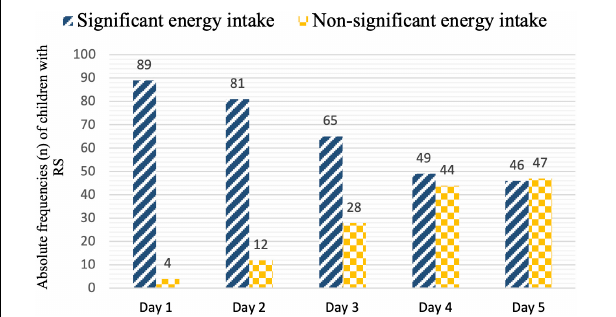
FIGURE 6 | Absolute frequencies ( n ) of significant versus non-significant daily intakes within the children with Refeeding Syndrome (RS) ( n = 93). Significant intakes are considered: Day 1 intakes > 25% of energy target, Day 2 intakes > 50% of energy target, Day 3 intakes > 75% of energy target, Days 4 and 5 intakes > 100% of energy